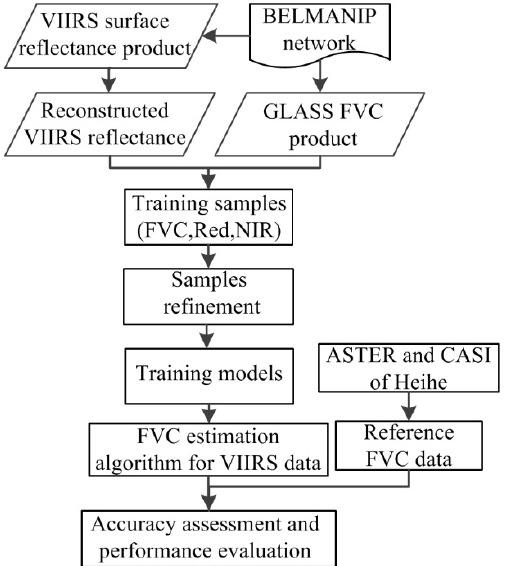
Figure 3. Global fractional vegetation cover (FVC) estimation algorithm flowchart for Visible Infrared Imaging Radiometer Suite (VIIRS) surface reflectance data.